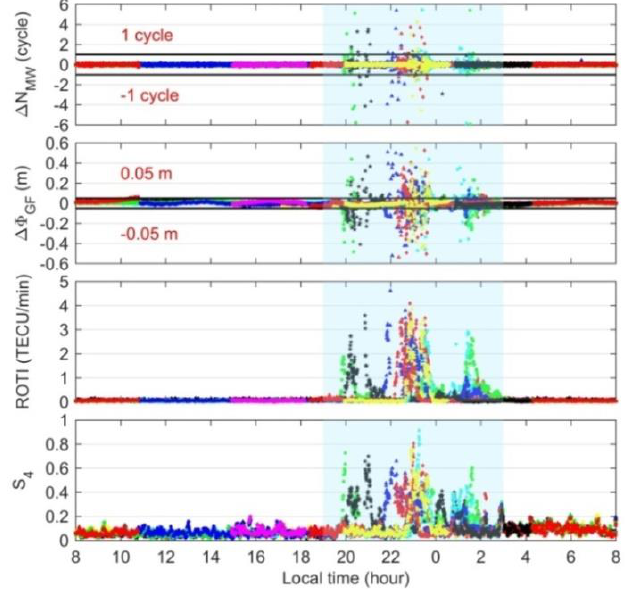
Figure 5. Fluctuations of BDS ∆ N MW , ∆Φ GF , ROTI, and S 4 for the HKST station on 20 October 2015 (DOY 293).